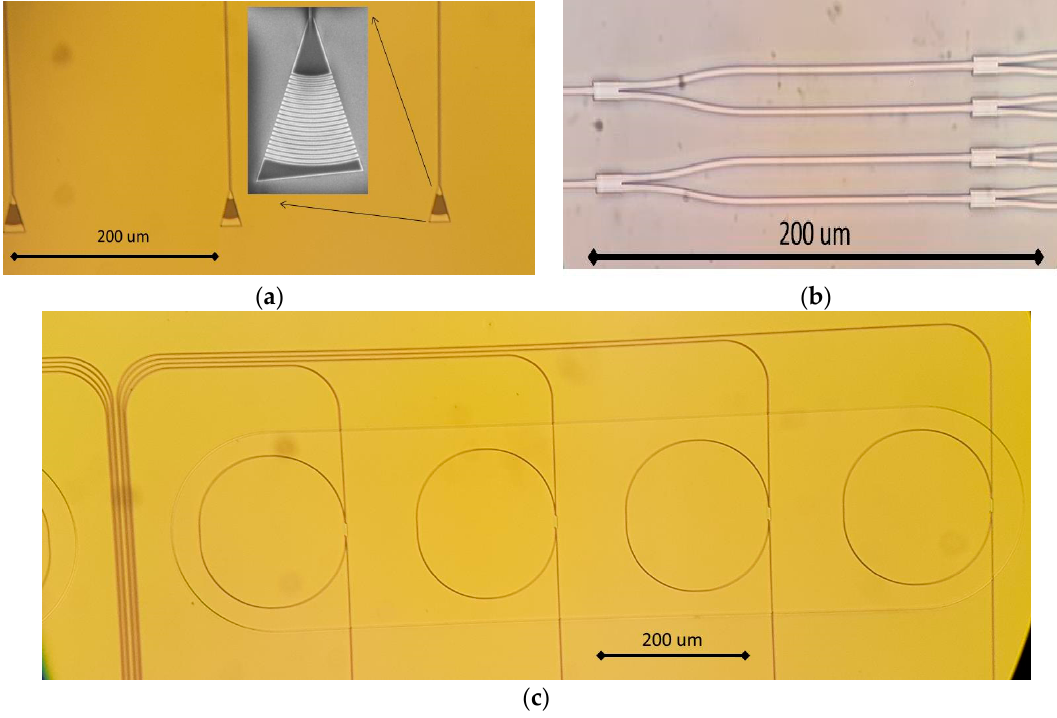
Figure 1. Microscope images of the fabricated biosensorPhotonic Integrated Circuit( PIC) building blocks; ( a ) grating coupler, ( b ) power splitting block, and ( c ) ring blocks; ( a ) grating coupler, ( b ) power splitting block, and ( c ) ring resonators).